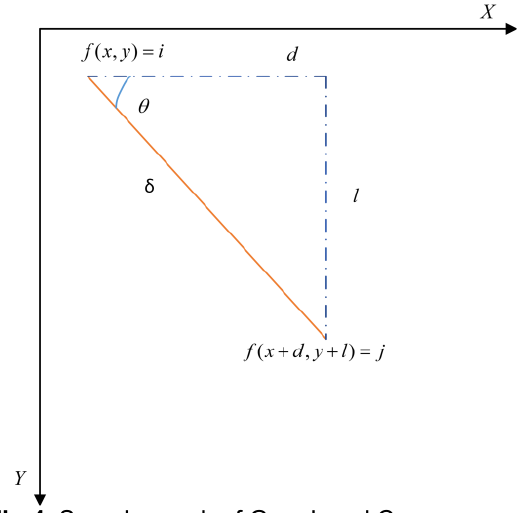
Fig 4. Sample graph of Gray Level Co-occurrence